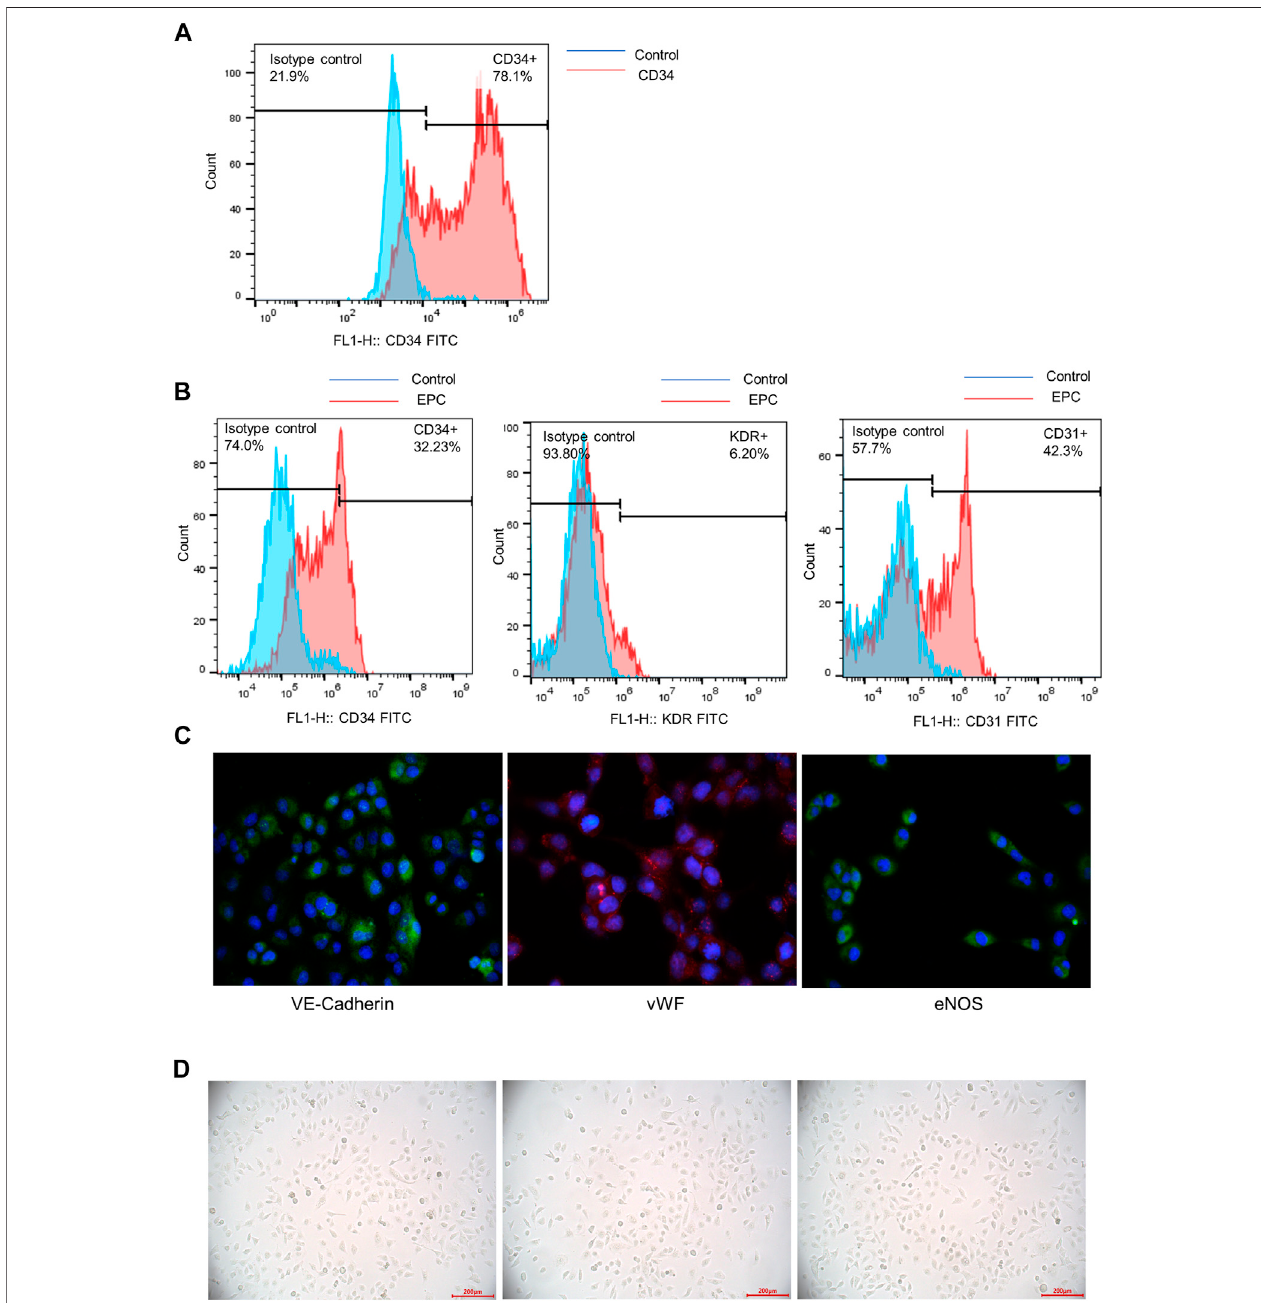
FIGURE 1 | Identi fi cation of CD34 + hematopoietic stem cells and differentiation of CD34 + hematopoietic stem cells to early EPC. (A) The purity of CD34 + hematopoieticstemcellswasaccessedbya fl owcytometryanalysis. (B) Flowcytometryanalysiswasusedtodetecttheexpressionofsurfacemarkers(CD34,KDRand CD31) of EPCs derived from CD34 + cells. (C) The immuno fl uorescence staining was used to examine the speci fi c biomarkers of the endothelial cells on the cell surface (VE-Cadherin, vWF and eNOS). (D) The morphological features of EPCs derived from CD34 + hematopoietic stem cells were observed using a